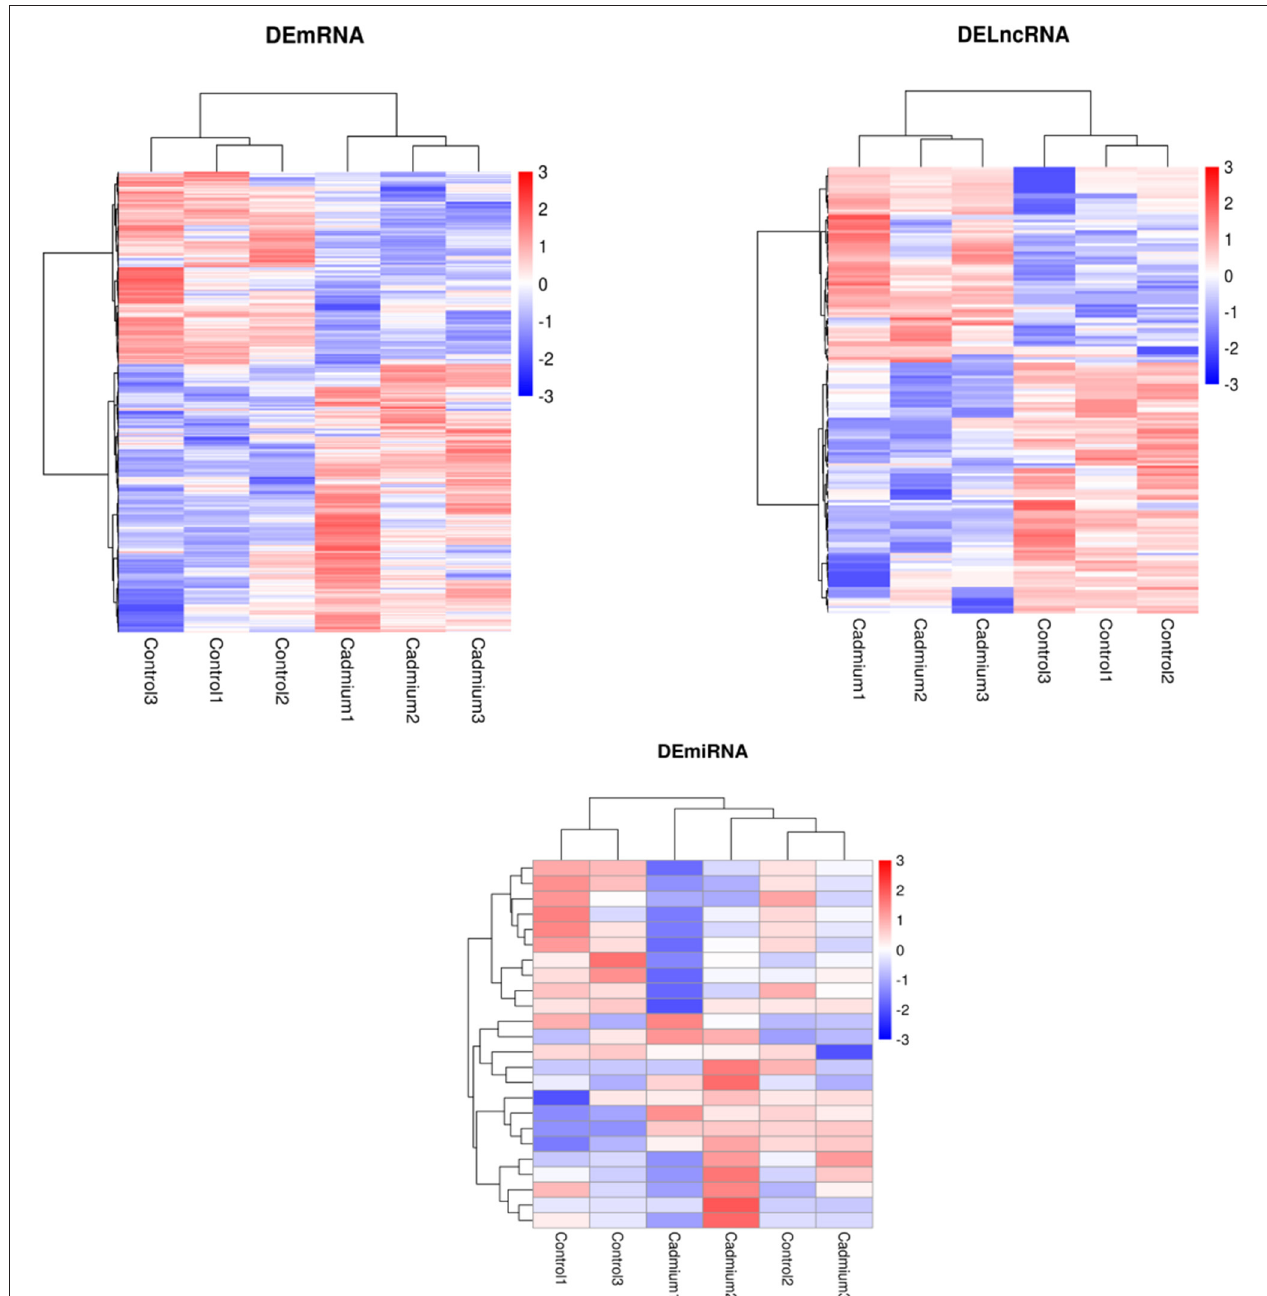
FIGURE 4 | Heatmap of DEmRNAs, DElncRNAs, and DEmiRNAs clustering analysis. Red represents upregulated genes, and blue represents downregulated genes.